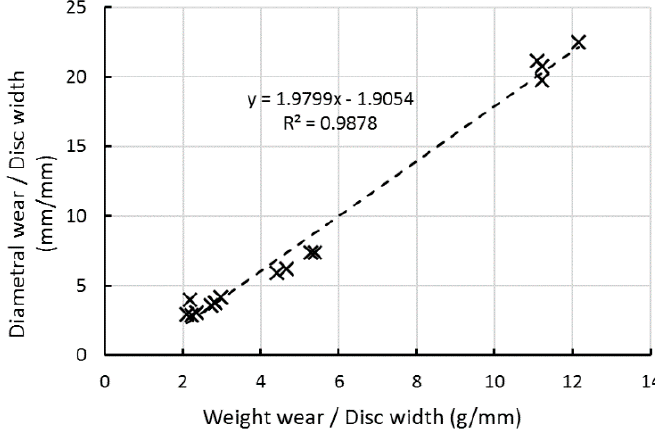
Figure 2. Correlation between radial wear and disc weight loss per disc width.